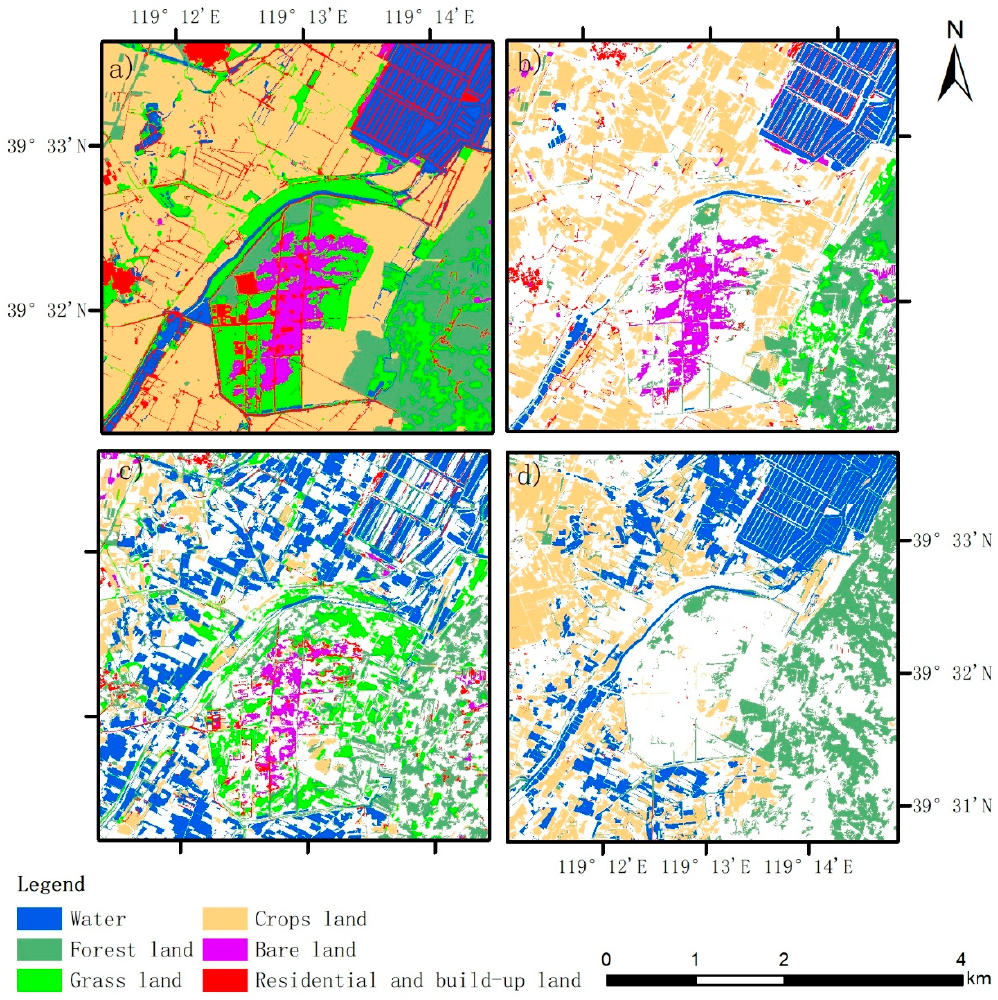
Figure 8. The validation area without original samples. The expert interpreted land cover result is shown in ( a ). The sample augment results of NNSA, LP, and DNN are shown in ( b ), ( c ) and ( d ), respectively.